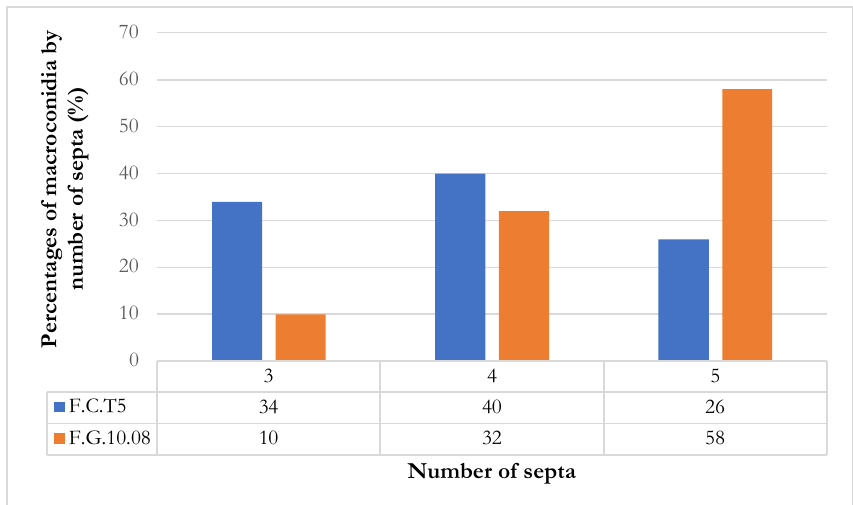
Figure 10. Percentages of macroconidia of each isolate according to the number of septa